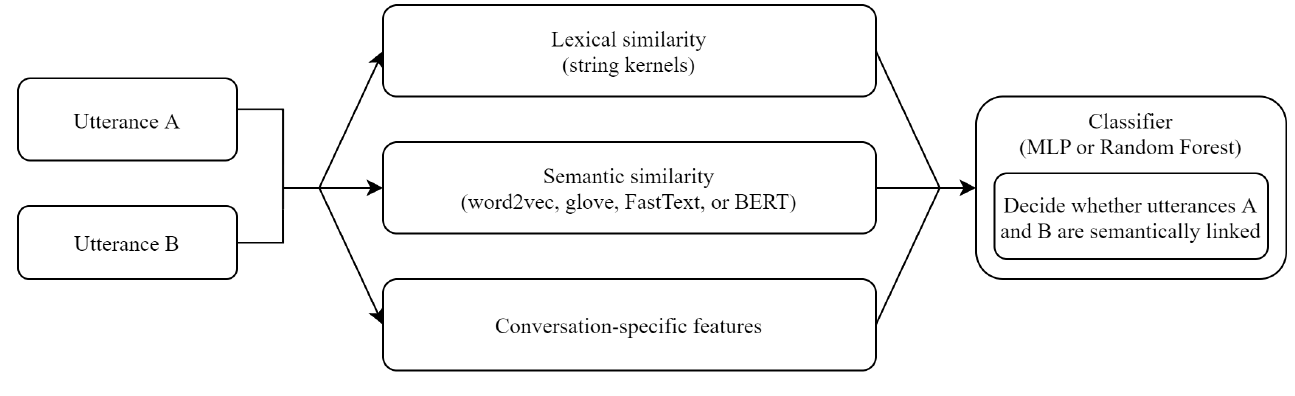
Figure 1. Conceptual diagram of our